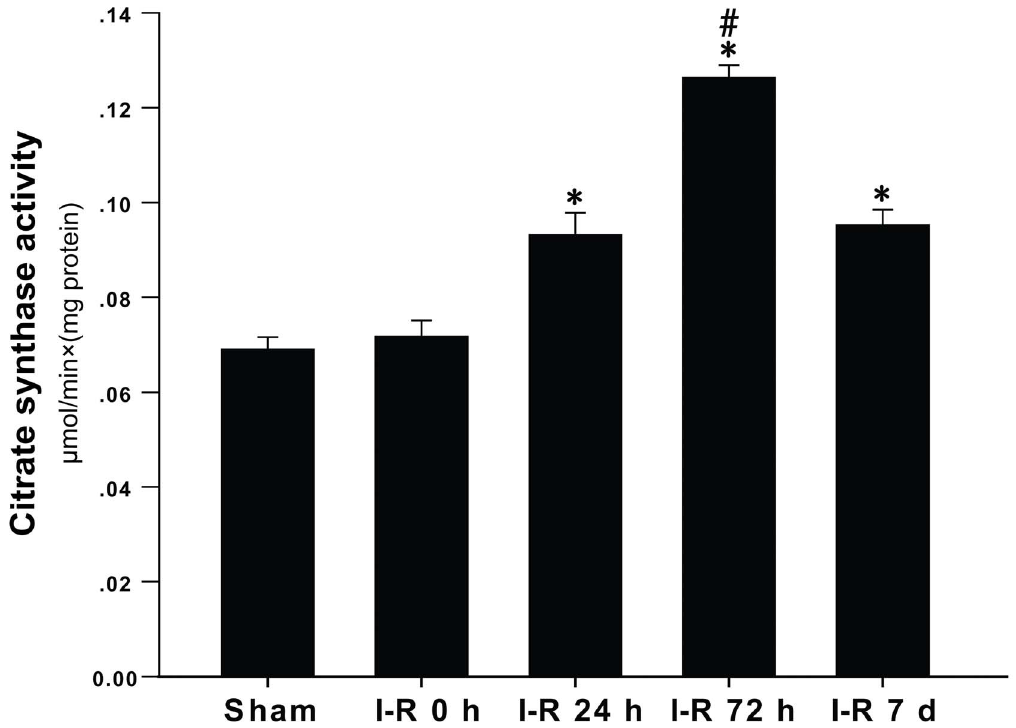
Figure 5. Changes in the citrate synthase activity. The citrate synthase activity was expressed as ( m mols of substrate transformed) 6 min 2 1 6 (mg protein) 2 1 of citrate synthase. The data are expressed as the means 6 SD. *P , 0.05 versus the I-R 0 h and sham groups; # P , 0.05 versus the I-R 24 h and I-R 7 d groups.